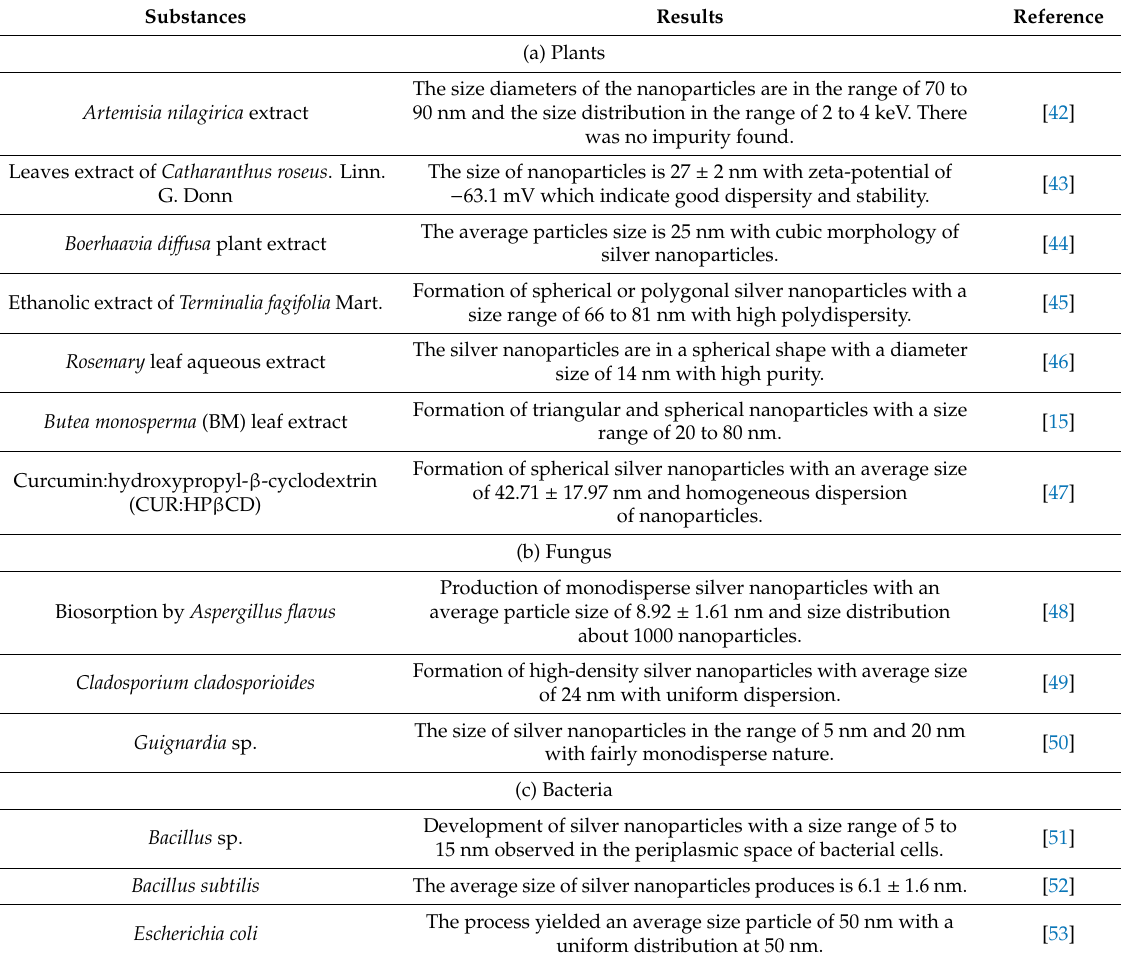
Table 3. The green synthesis of silver nanoparticles